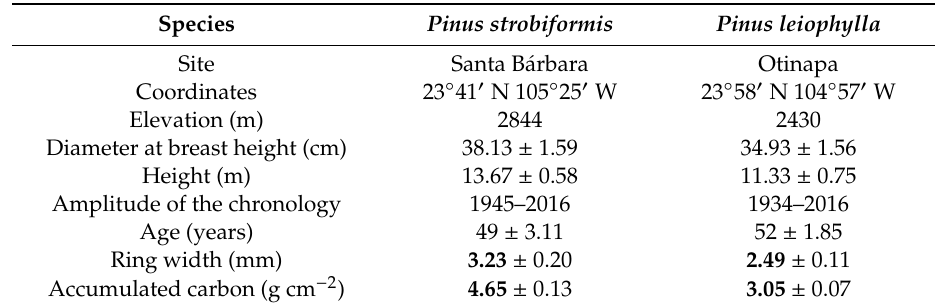
Table 1. Average characteristics of the trees studied in the dendroclimatic analysis. The expressed population signal (EPS) was > 0.85 for the analyzed period